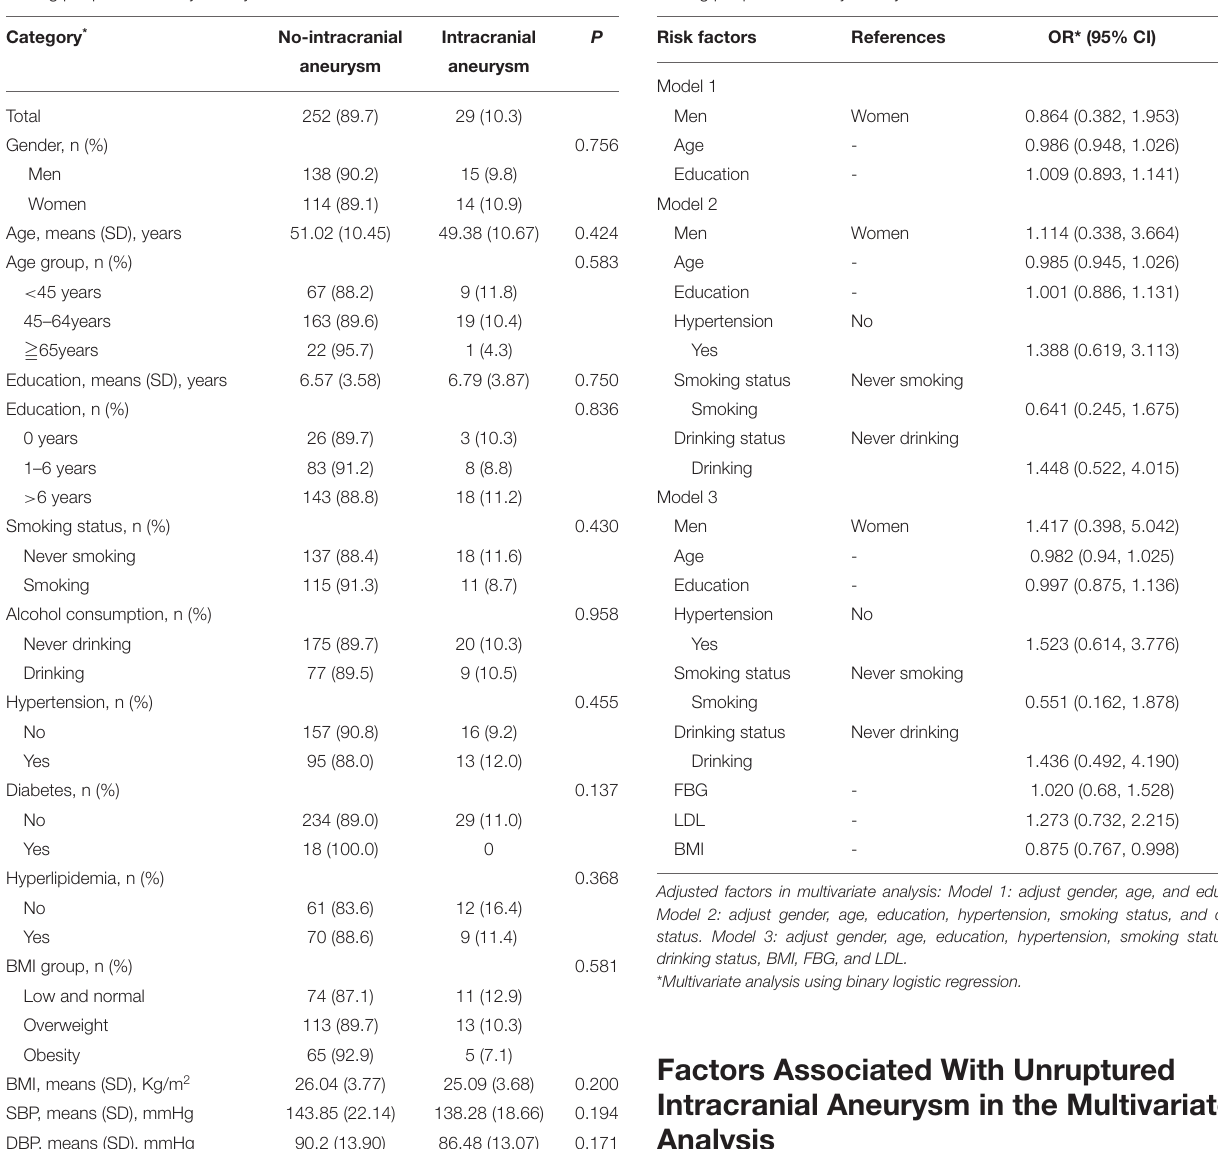
TABLE 3 | Associated factors of intracranial aneurysm in the multivariate analysis among people with family history of